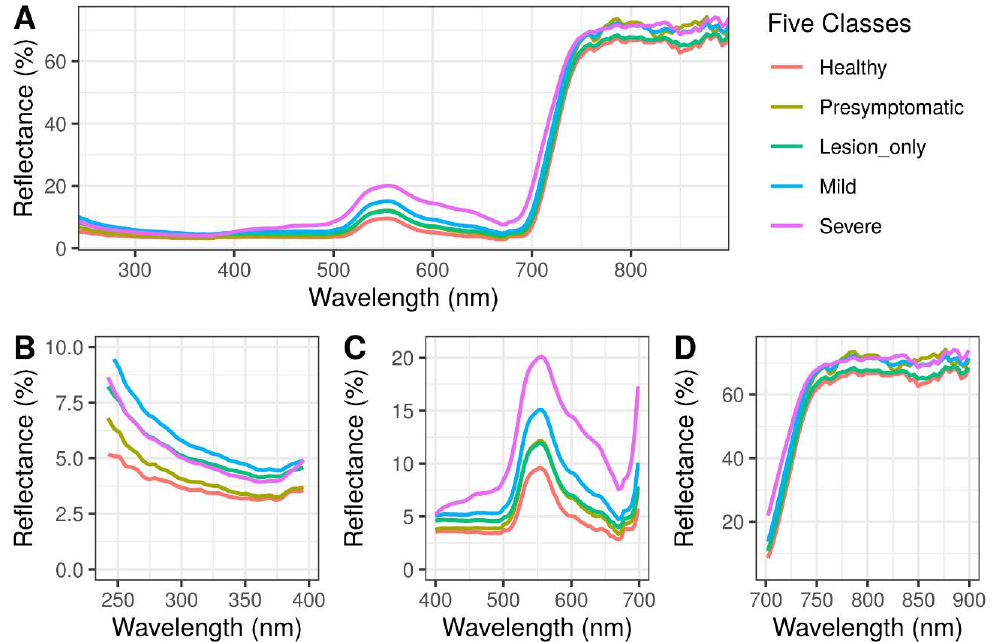
Figure 2. Spectral profiles of healthy and peanut plants infected with Athelia rolfsii at different stages of disease development. ( A ) Entire spectral region (240 to 900 nm); ( B ) Ultraviolet region (240 to 400 nm); ( C ) Visible region (400 to 700 nm); ( D ) Near-infrared region (700 to 900 nm).